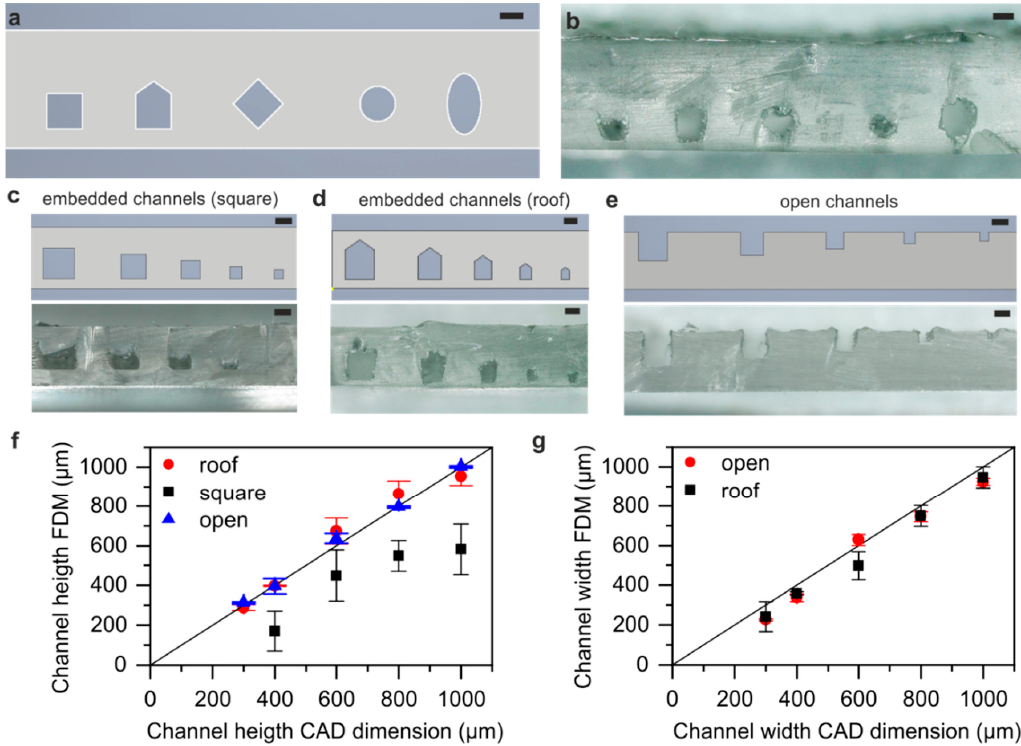
Figure 2. Characterization of the channel cross-section of a printed PMMA chip. ( a ) Image of the design of the printed channel cross-sections. ( b ) Different channel cross-sections with a channel width/diameter of 600 µm printed in PMMA. ( c ) Fused deposition modeling (FDM) printed embedded channels with a square cross-section for analysis of the printed channel height. Due to sagging the channel height deviates strongly from the original CAD design. ( d ) FDM printed embedded channels with a roof shaped cross-section for analysis of printed channel height and width. The addition of the roof compensates the sagging resulting in square channels. ( e ) Open square cross-section channels for analysis of the channel height and width. ( f ) Comparison of channel heights of embedded FDM printed channels using square and roof shaped cross-sections shown in ( c , d ) and open channels shown in ( e ) with the designed CAD heights. ( g ) Channel width of open and embedded roof shaped FDM printed channels from ( d , e ) compared to the designed CAD widths. (Scale bars ( a – e ): 500 µm).